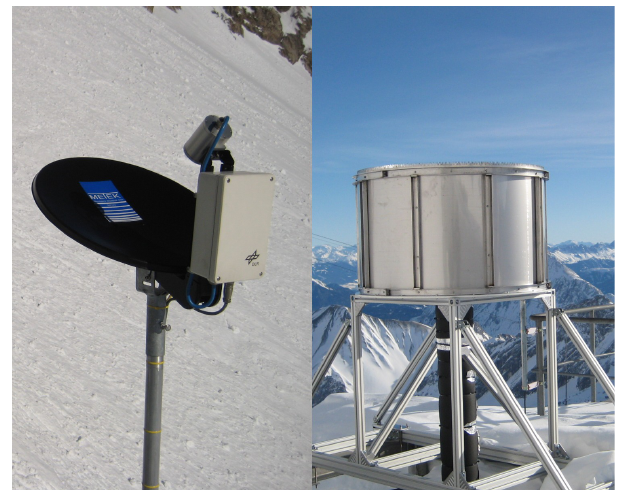
Fig. 1. Micro Rain Radar 2 (MRR) (left) and MIRA35 cloud radar (right) at the UFS